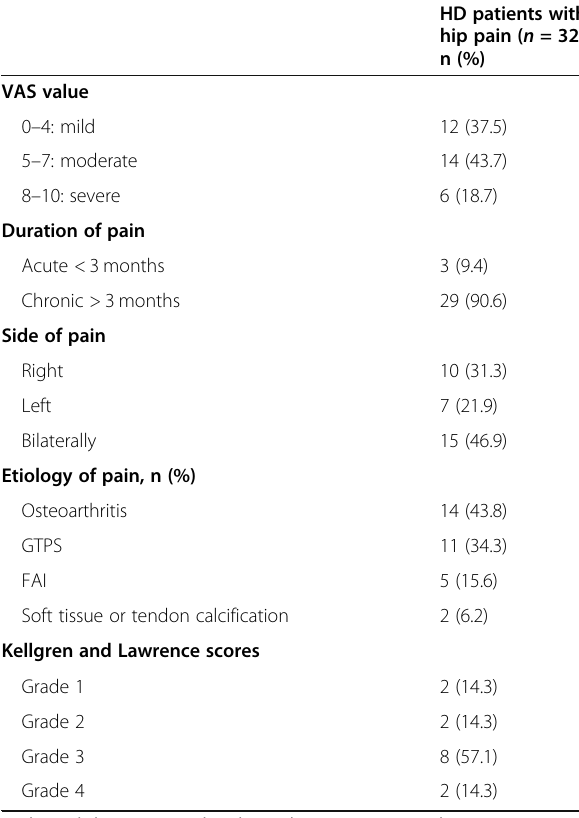
Table 4 Multivariate analysis of risk factors for hip pain in